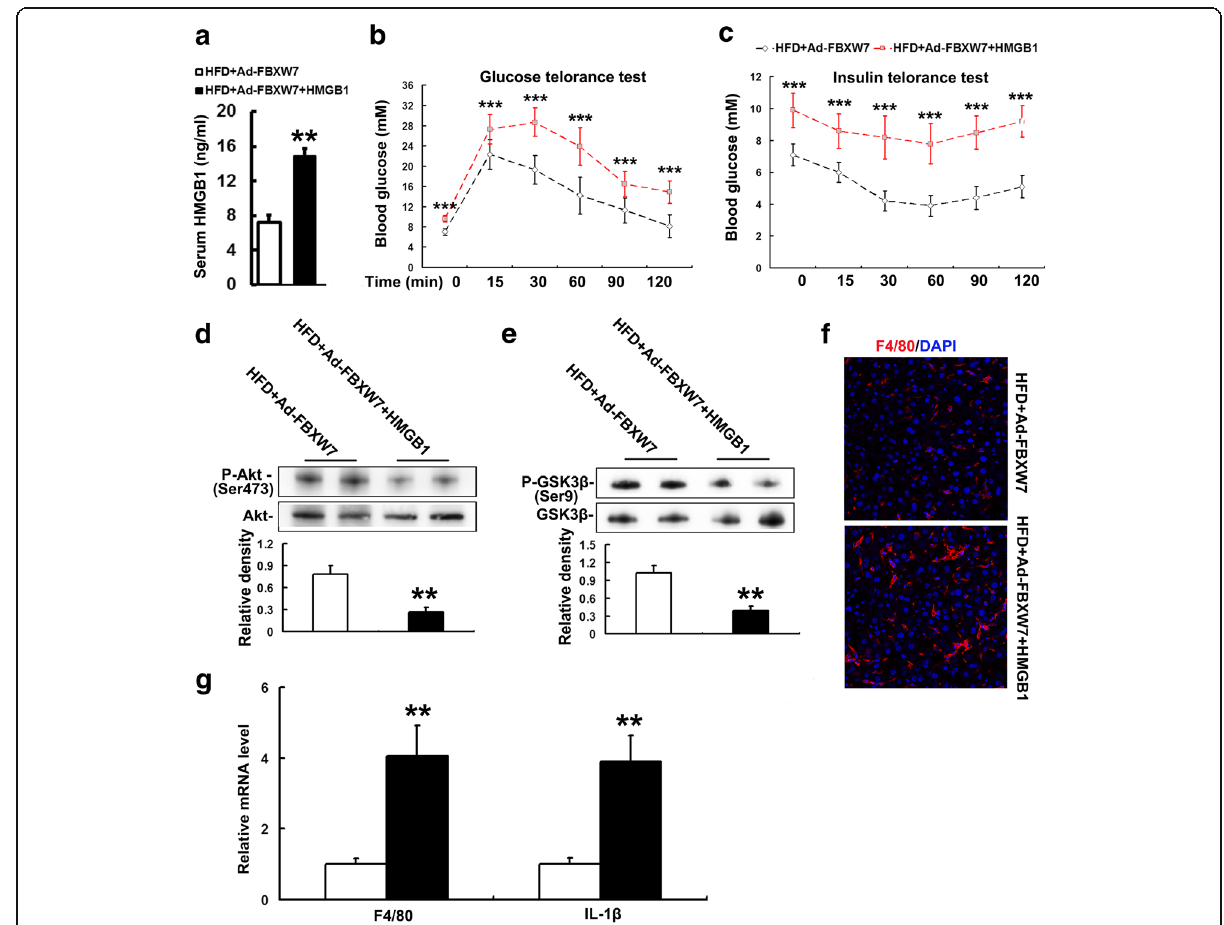
Fig. 7 Exogenous HMGB1 abolishes FBXW7 overexpression-mediated improvement of insulin resistance and inflammation in HFD-fed mouse livers. a Serum HMGB1 levels in different treatment groups ( n = 4). b Data of glucose tolerance tests in different treatment groups ( n = 4). c Data of insulin tolerance tests in different treatment groups ( n = 4). d Immunoblotting and densitometry of p-Akt in mouse livers ( n = 4). e Immunoblotting and densitometry of p-GSK3 β in mouse livers ( n = 4). f Representative confocal immunofluorescence images of F4/80 (red) and DAPI (blue) in mouse livers ( n = 4). g The mRNA level of inflammation-related genes in mouse livers ( n = 3). All of the values are expressed as the mean ± SD. ** P < 0.01, *** P < 0.001 versus the HFD + Ad-FBXW7